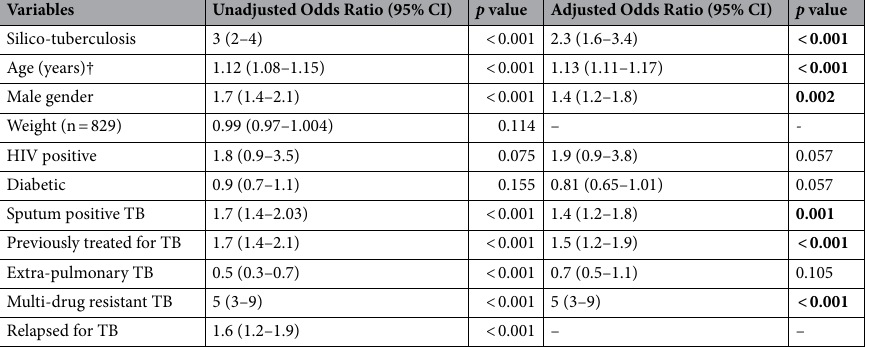
Table 2. Univariable and multivariable logistic regression * for variables predicting unfavorable treatment outcomes in Khambhat block (n = 2748). *Model statistics: Omnibus chi-square = 173 ( p value < 0.001); Hosmer–Lemeshow p value = 0.027; Nagelkerke r 2 = 0.099; classification accuracy = 82% † Calculated for a five- year increment in age. Significant values are in